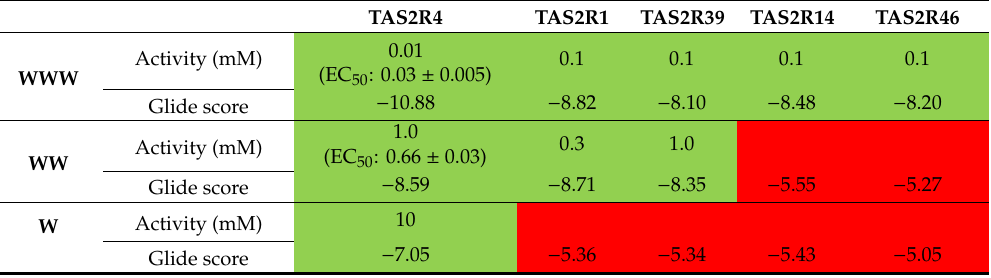
Table 1. Glide SP scores (kcal / mol) of mono-to-tri-tryptophans docked into peptide-sensitive TAS2Rs. Activity values (threshold and EC 50 when available) of TAS2Rs activated by mono-to-tri-tryptophans, as determined by Kohl et al. 2013 [16]. Cells are colored in green when the peptide was found to be active with the calcium-imaging assay and in red if potency could not be